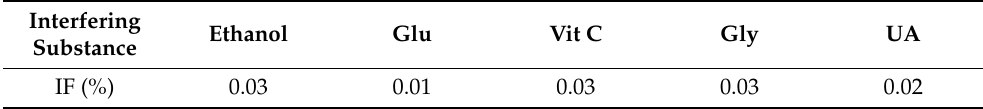
Figure 9. ( A ) Storage stability of Chi/HFs-Lac/MWCNTs-CTAB/GCE in 50 mmol L − 1 pH 4 phosphate-buffered solution containing 5 µmol L − 1 rutin. (The biosensor has stored at 4 °C for 0, 10, 20, 30 days.) ( B ) Anti-interference ability of Chi/HFs-Lac/MWCNTs-CTAB/GCE in 50 mmol L − 1 pH 4 phosphate-buffered solution containing 250 µmol L − 1 different interfering substance (ethanol, Glu, Vit C, Gly, UA) and 0.5 µmol L − 1 rutin. Table 2. The IF values of different interfering